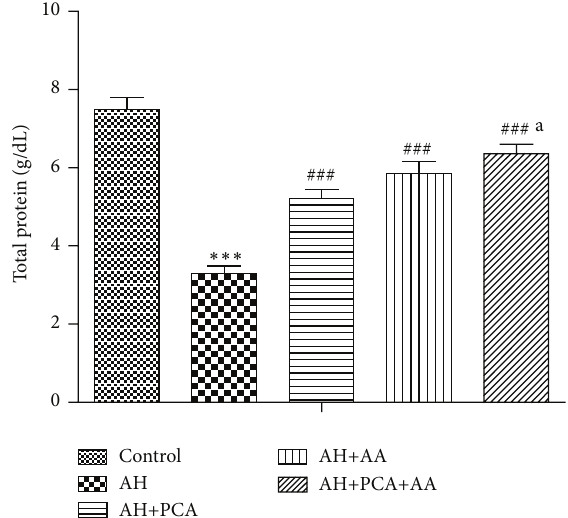
Figure 3: Effect of PCA alone and in combination with AA on total protein in AH-treated rats. Values are expressed as mean ± SEM. Level of significance is considered as ∗ 𝑝 < 0.05 , ∗∗ 𝑝 < 0.01 , and ∗∗∗ 𝑝 < 0.001 compared to control group. # 𝑝 < 0.05 , ## 𝑝 < 0.01 , and ### 𝑝 < 0.001 compared to AH-treated group. a 𝑝 < 0.05 compared to AH+PCA and b 𝑝 < 0.05 compared to AH+AA